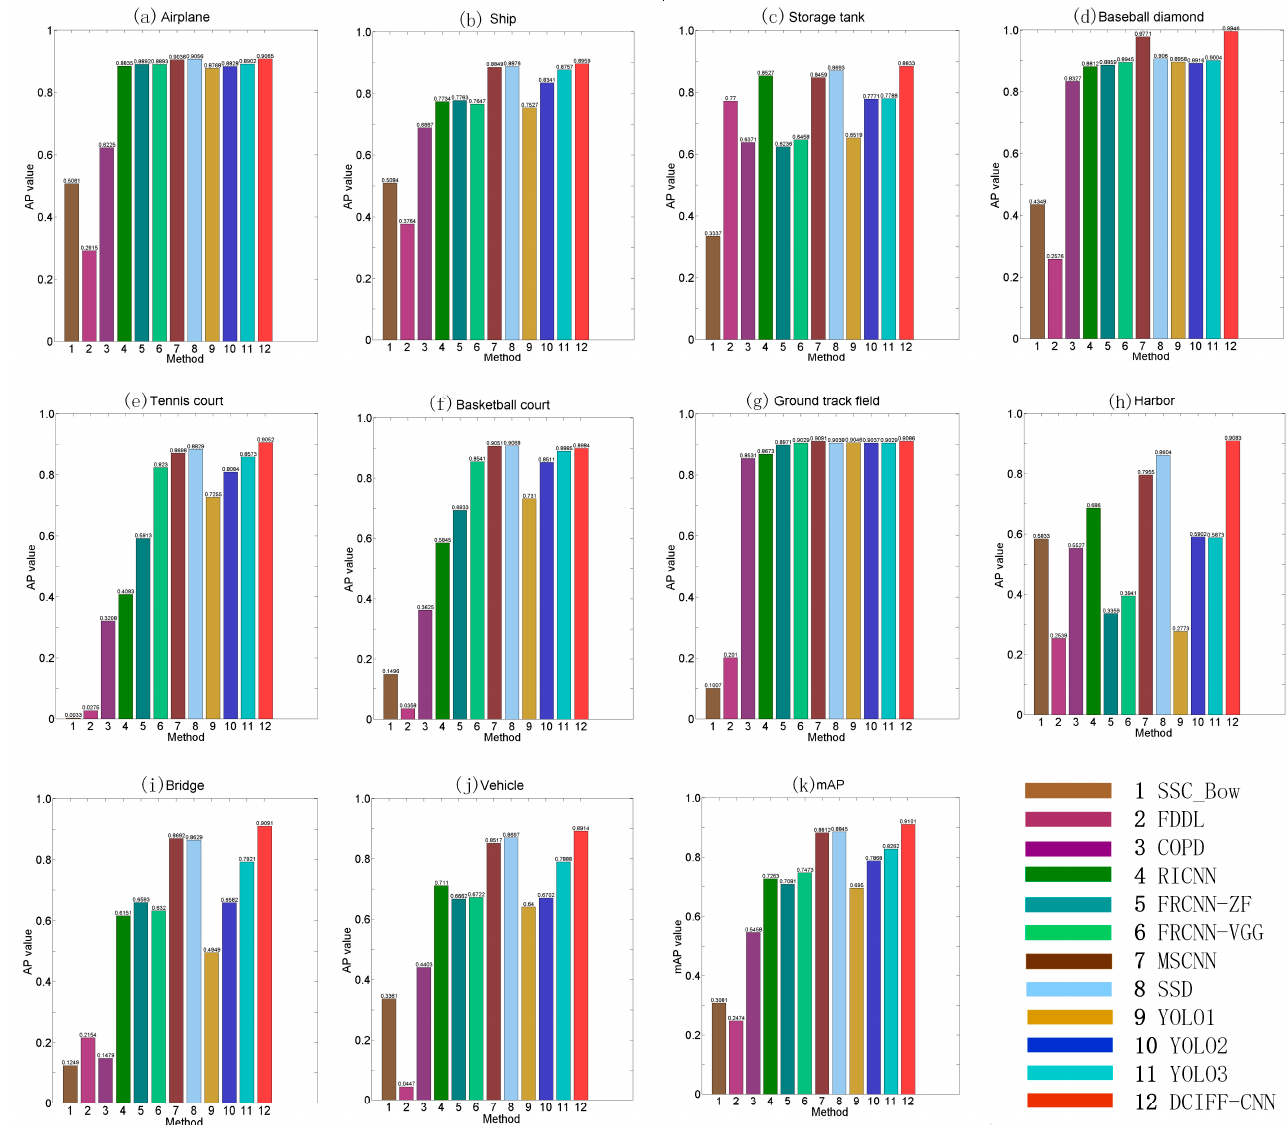
Figure 8. Performance comparisons of twelve different methods in terms of average precision (AP) values. ( a ) The AP value of an airplane; ( b ) The AP value of a ship; ( c ) The AP value of a storage tank; ( d ) The AP value of a baseball diamond; ( e ) The AP value of a tennis court; ( f ) The AP value of a basketball court; ( g ) The AP value of a ground track field; ( h ) The AP value of an harbor; ( i ) The AP value of a bridge; ( j ) The AP value of a vehicle; ( k ) The mAP value of ten classes of targets. All the methods are carried out with the same dataset and the same data ratio (Dataset: NWPU-VHR (train:20%, val:20%, test:60%)).